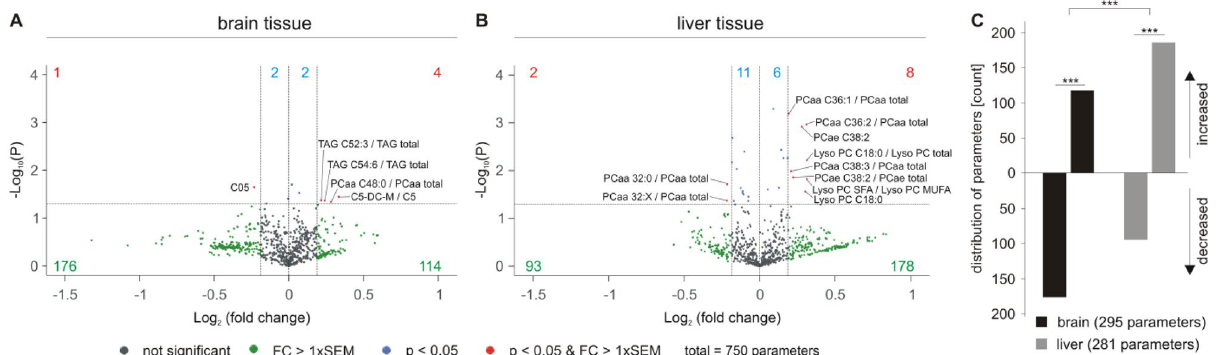
Figure 2. Lipid changes in acitretin-treated AD model mice compared to AD transgenic mice not treated with acitretin. Fold changes of 750 parameters are plotted logarithmically against the p value (−Log 10 ) for brain ( A ) and liver tissue ( B ) of 5xFAD mice. Those lipid species without significant changes are represented as grey dots, those with a fold change greater than the average SEM as green dots. Species with a significant ( p < 0.05) fold change are highlighted in blue and those with a p value < 0.05 and a fold change greater than the SEM are marked as red dots in the volcano plot. The exact number of changed parameters in every part of the volcano plot is written in the appropriate color. ( C ) Distribution of parameters with a fold change greater than the average SEM represented as number of de- and increased parameters in brain and liver tissue in a bar chart. The total number of parameters used in the statistical analysis is indicated. Statistical significance of the observed shifts in de- and increased parameters in brain or liver tissue was calculated using binomial test. For analysis of significant differences in lipid distribution between brain and liver tissue Fisher´s exact test was